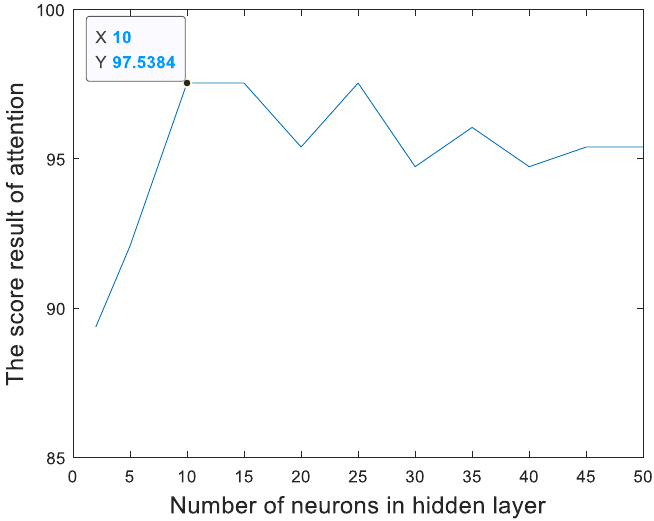
Figure 13. The relationship between the percentage of the classification accuracy and the total number of neurons in the hidden layer of the BP neural network in our proposed method trained using the EEGs acquired from Hejian performing the reading activity under the concentration state on the first day.